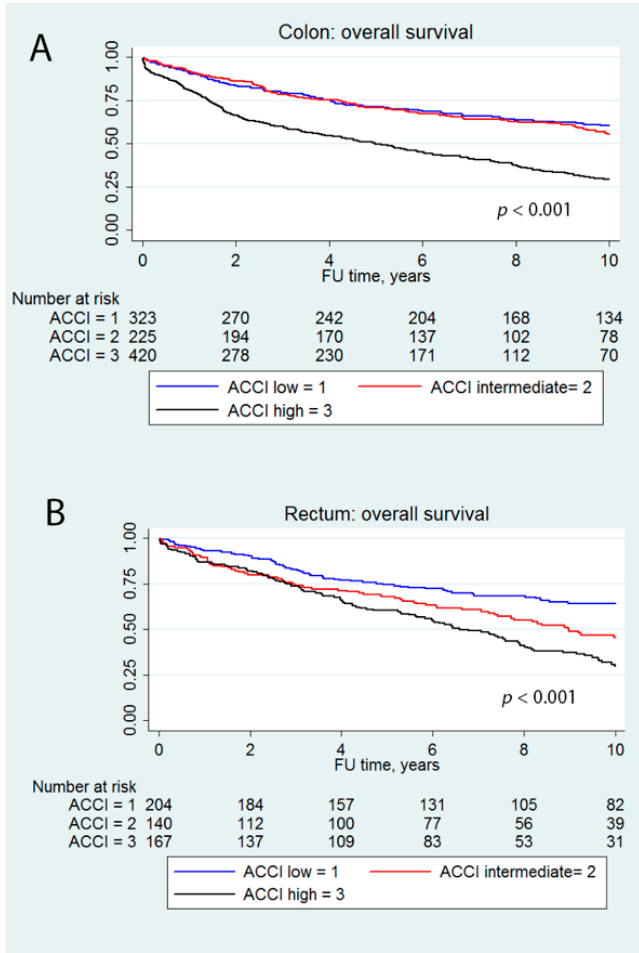
Figure 2. Five-year overall from stages I–IV colon carcinoma ( A ) and rectal carcinoma ( B ). In multivariable Cox proportional hazard analysis (Table 3) ACCI, male gender, UICC Table 3. Univariate and multivariable Cox proportional hazard analysis for overall survival. stage and type of surgery at presentation were independent prognostic factors for colon carcinoma and UICC stage and ACCI for rectal carcinoma overall